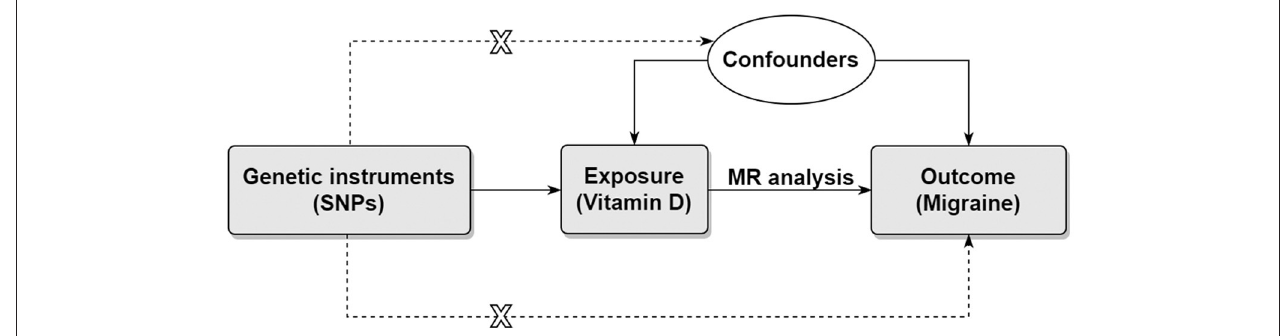
FIGURE 1 | Directed acyclic graph representing the Mendelian randomization framework. There were three core assumptions for two-sample MR method. Assumption 1: the instrument SNP is associated with the exposure of interest. Assumption 2: the instrument SNP does not affect outcome via pathways other than the exposure. Assumption 3: the instrument SNP is not associated with confounders. Horizontal pleiotropy will present if the effect of the instrument SNP on the outcome was all or partially via other pathways. MR, Mendelian randomization; SNP, single nucleotide polymorphism.